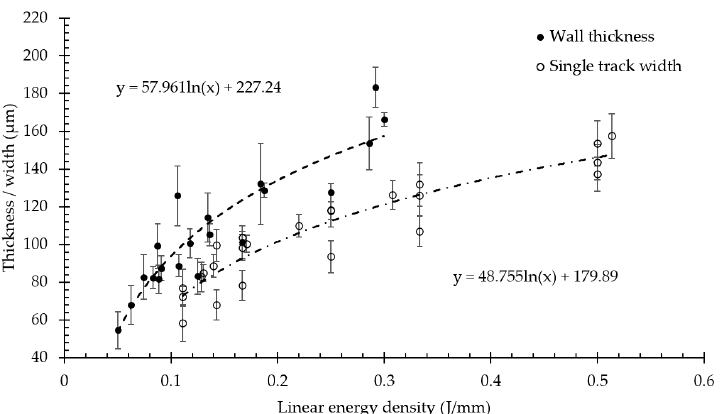
Figure 6. Dependence of wall thickness and width of single tracks [25] on linear energy density for vertical samples. vertical